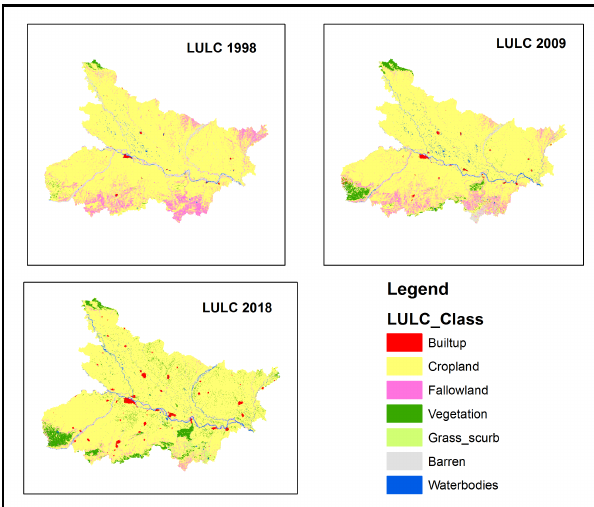
Figure 3. Classified map of Bihar using